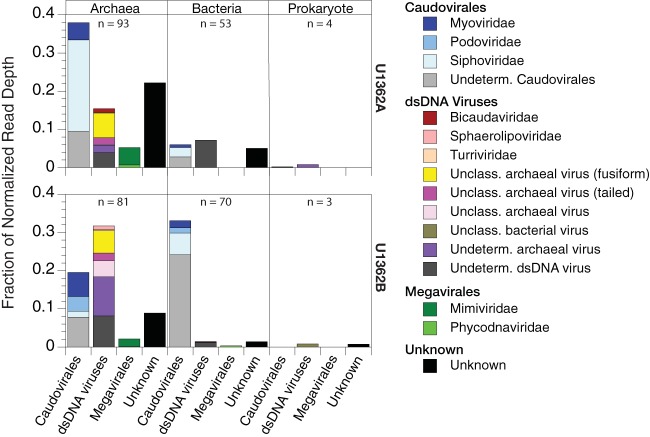
Consensus taxonomic affiliation of the best BLASTP hits for the genes on the virus-like scaffolds identified by VirSorter in metagenomes from U1362A or U1362B using only viral sequences from RefSeq as the target database and clustered by the most likely domain for the putative host of the virus. The data are presented as the fraction of scaffolds classified in each category after normalizing for read depth, but the absolute number of scaffolds (n) is also shown for each host category. “Unclassified (Unclass.)” indicates significant similarity (E value of 10−5) to specific viruses that are not yet classified in the NCBI taxonomy database (as of 2 September 2016). “Undetermined (Undeterm.)” indicates that there was no consensus in the taxonomy among the significant BLAST hits beyond the level of order. “Unknown” classifications indicate no significant hits to the viral RefSeq database. An exception to the NCBI-based taxonomy is the inclusion of Megavirales, which is currently a proposed, but not yet official, order (69).